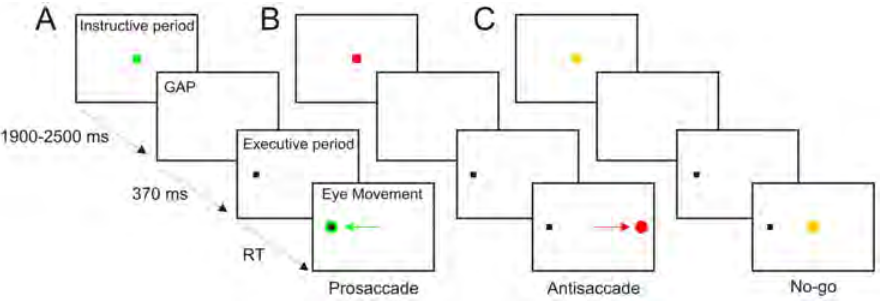
Figure 1. Experimental design. The experimental session involved 240 trials of intermixed prosaccadic (A), antisaccadic (B) and no-go (C) trials. Each trial comprised an instructive period in which a central color square (S1) on a white background identified the type of task trial (red for antisaccade, green for prosaccade or yellow for no-go) during a variable time of 1900–2500 ms. The central color square was switched off during 370 ms (gap period) and a peripheral black dot target (S2) appeared, randomly located at 8 deg on the left or right side, indicating the executive period. Subjects were instructed to execute eye movements with the shortest possible reaction time (RT) after S2. Arrows indicate the correct direction of the eye movement in each task and the color circle the appropriate final position of the